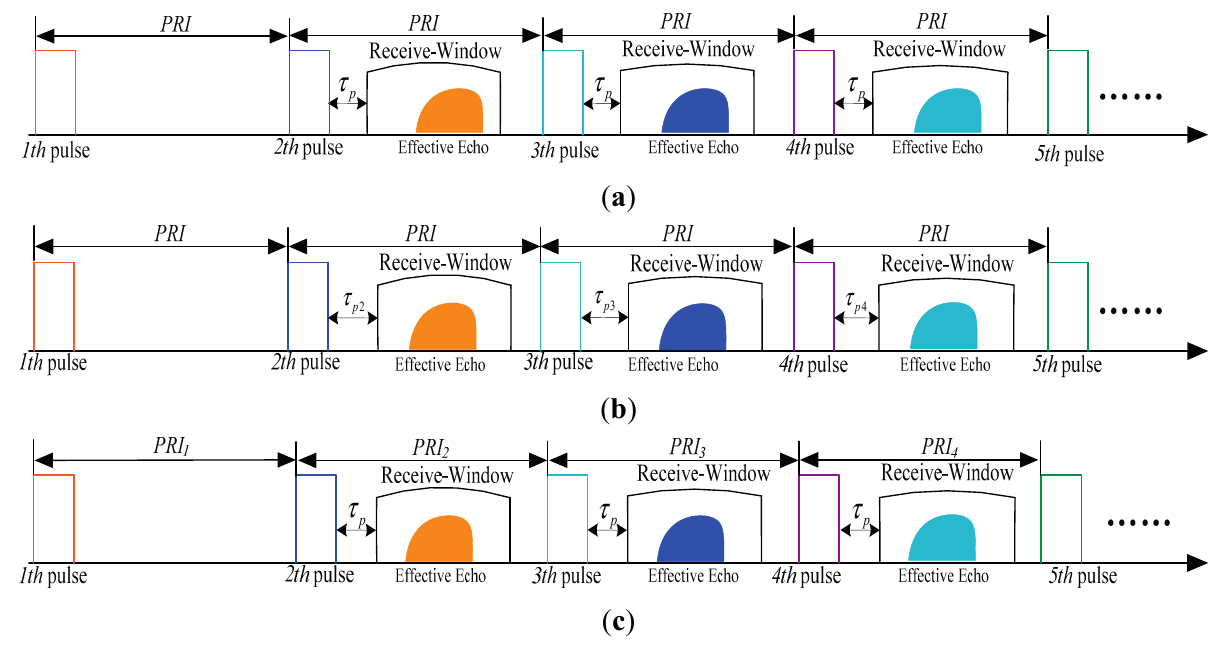
Figure 2. Different SAR working modes. ( a ) Constant PRI and fixed receive-window; ( b ) Constant PRI and sliding receive-window; ( c ) Variable PRI and fixed receive-window.